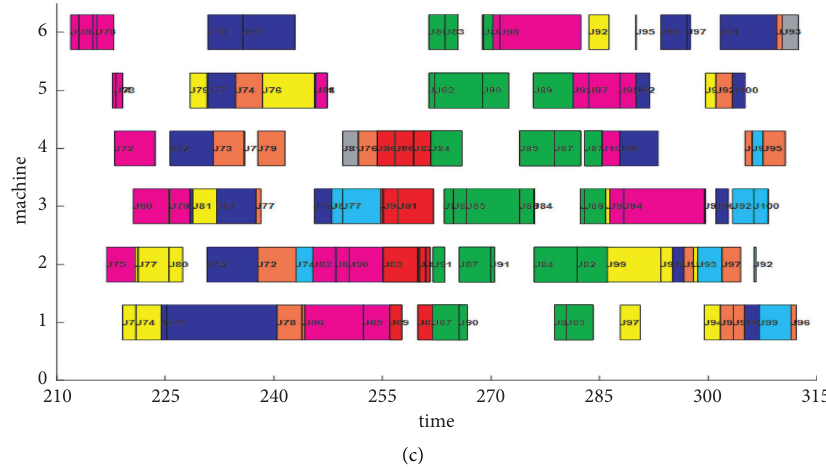
Figure 16: Final scheduling scheme in this paper. (a) t � 0–3 t